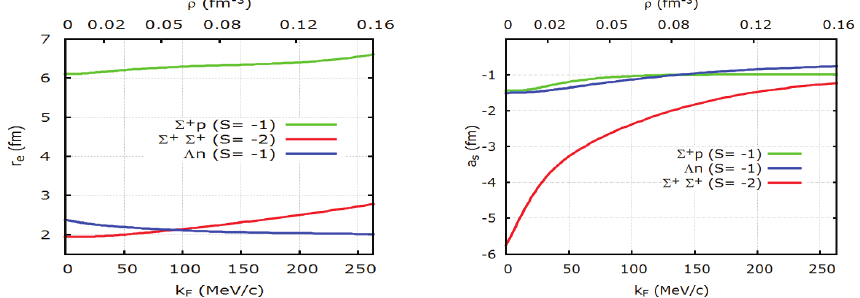
Figure 3. Variation of e ff ective range ( r e ) (left) and scattering length ( a s ) (right) with nuclear density (top) and Fermi momentum (bottom) revealing channel dependent